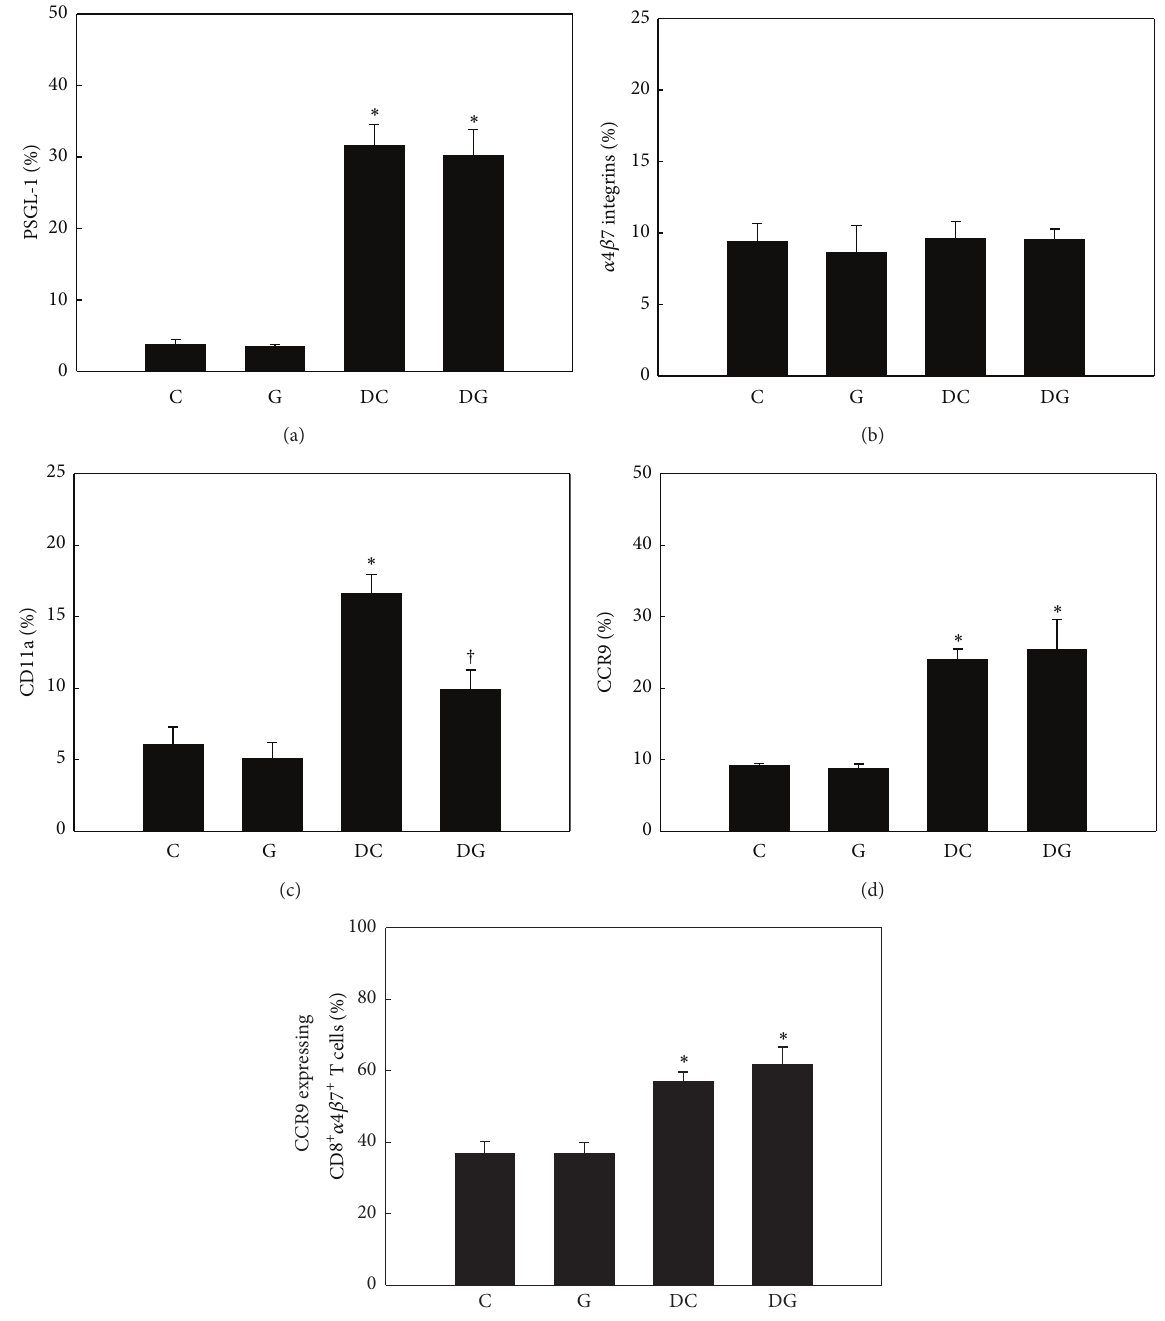
Figure 6: Percentage of adhesion molecule- and chemokine receptor-expressing cytotoxic T (Tc) cells in blood. CD8-positive blood lymphocytes were gated to analyze expressions of PSGL-1, 𝛼4𝛽7 integrins, CD11a, and CCR9 by flow cytometry ((a)–(d)). (e) Expression of CCR9 by CD8 and 𝛼4𝛽7 integrin double-positive blood lymphocytes. Values are shown as the mean ± SEM. ∗ Significantly different from the C group ( 𝑃 < 0.05 ). † Significantly different from the DC group ( 𝑃 < 0.05